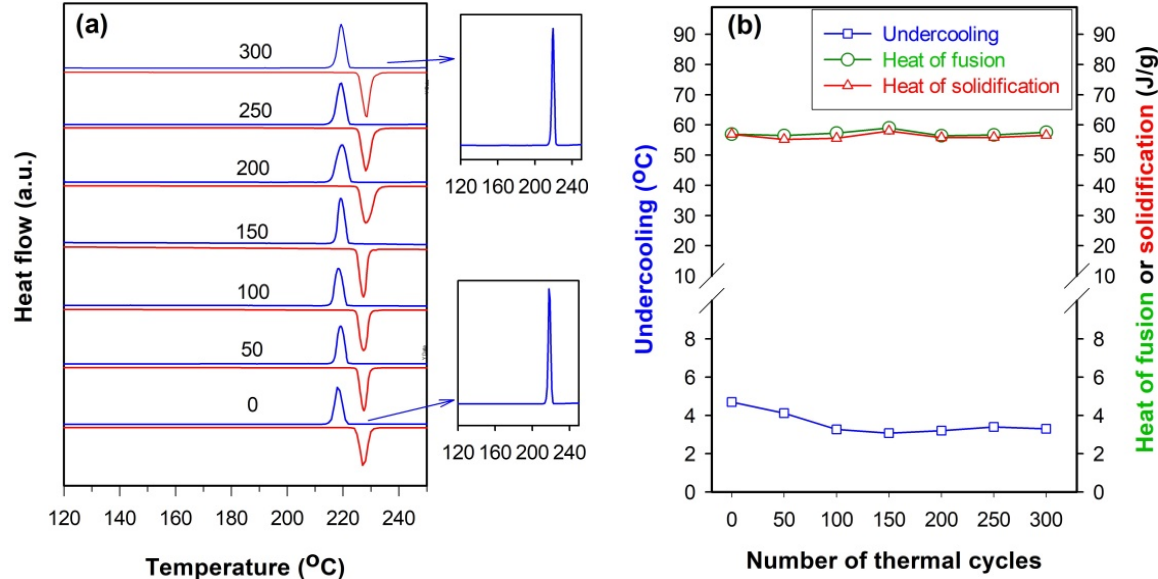
Figure 10. ( a ) DSC curves of SnZn 0.04 Cu 0.03 @SiO 2 microspheres (encapsulation times = 3) after different numbers of thermal cycles and ( b ) plot of both the undercooling and latent heat vs. the number of thermal cycles.